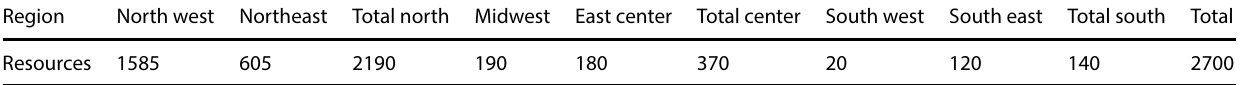
Table 1 Regional distribution of the Tunisian surface water resources (10 6 m 3 ) in 1995 [16]